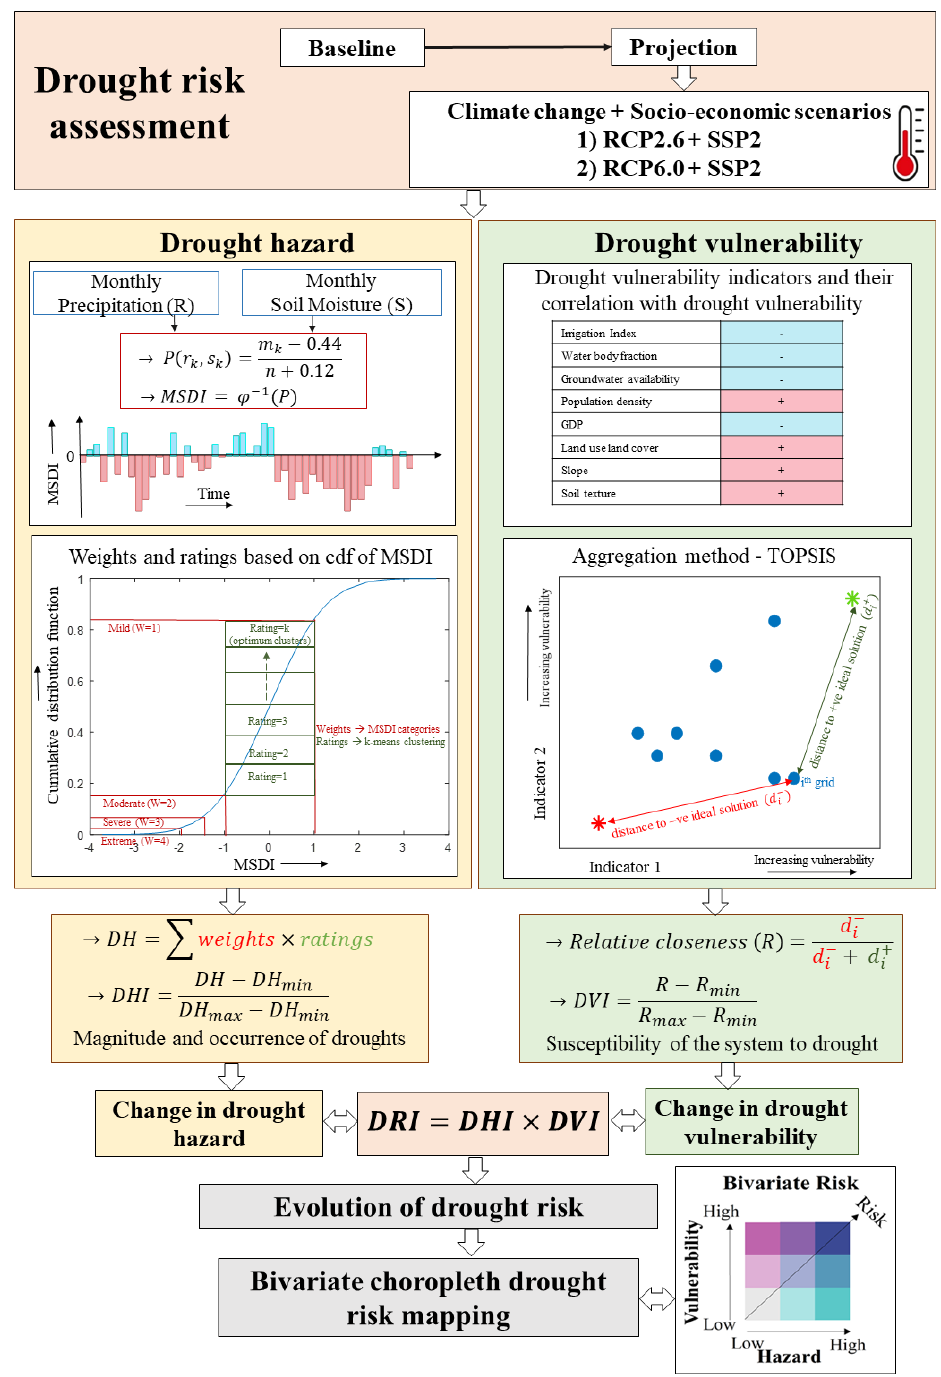
Figure 1. Framework to assess drought risk evolution. Monthly rainfall and monthly soil moisture are used to compute the multivariate standardized drought index (MSDI). Weights and ratings system of MSDI is adopted to further compute drought hazard index (DHI). Multi- criteria decision-making technique – TOPSIS – is used to calculate drought vulnerability index (DVI) considering eight drought vulnerability indicators. The product of DHI and DVI is the drought risk index (DRI). Drought risk assessment is carried out for the baseline (1980–2015), near-future (2021–2050) and far-future (2061–2100) periods for various climate and socio-economic scenarios.